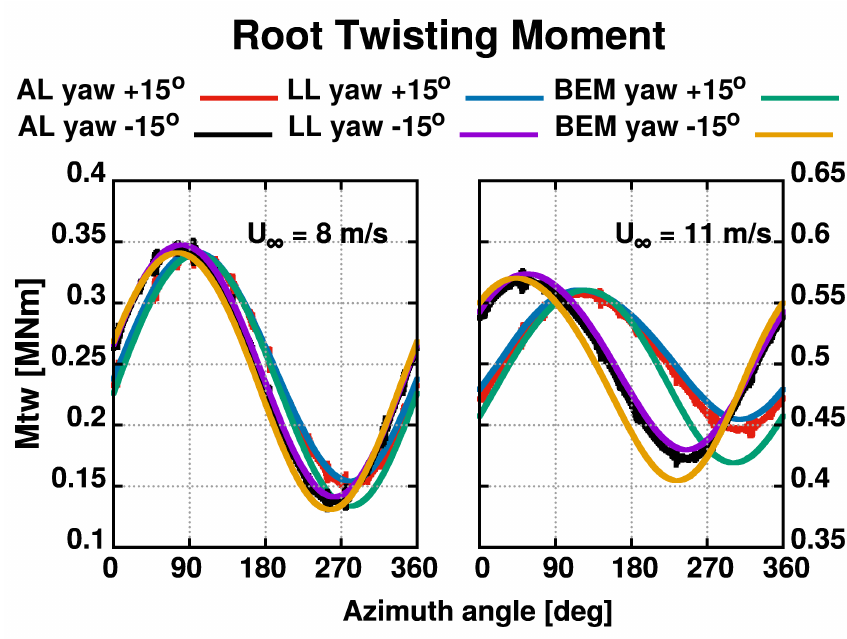
Figure 27. Twisting moment of blade root at 15 ◦ yawed wind speed at 8 and 11